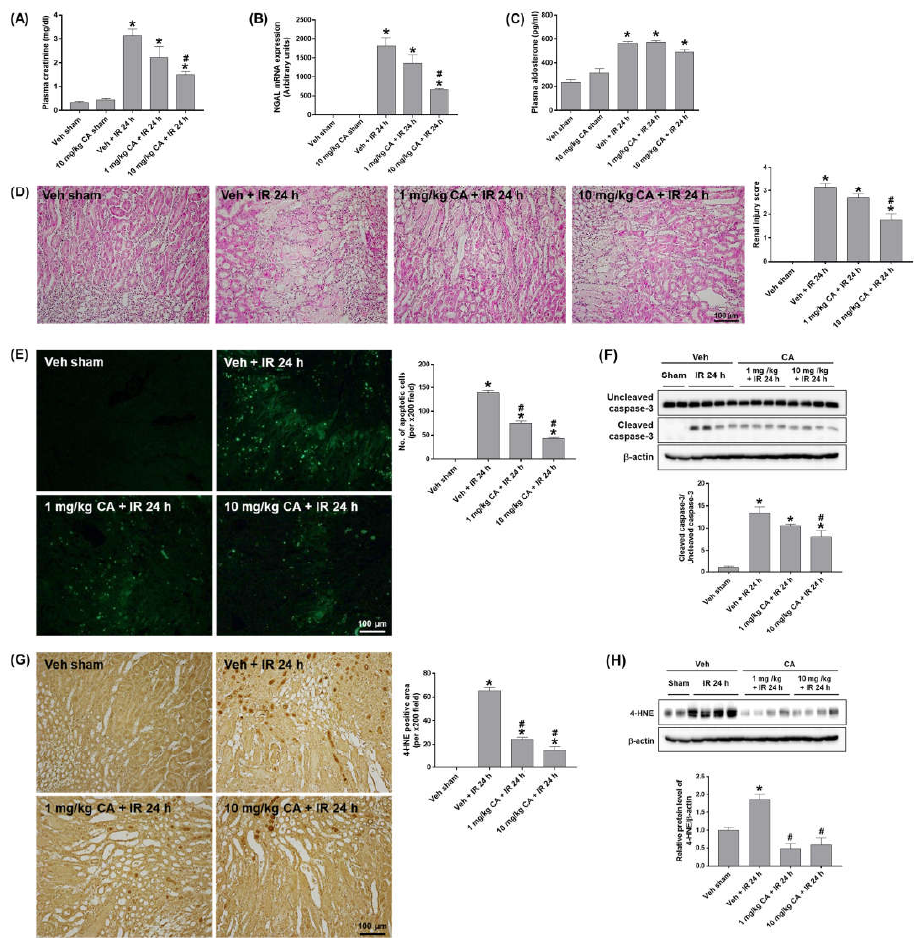
Figure 1. Canrenoic acid (CA) reduces plasma creatinine, tubular cell death, and oxidative stress in renal ischemia-reperfusion (IR) injury. C57BL/6 mice were subjected to 30 min of bilateral renal ischemia. CA (1 or 10 mg/kg) was injected intravenously 30 min prior to ischemia and sacrificed 24 h after reperfusion. Plasma creatinine levels ( A ), renal mRNA expression of NGAL ( B ), and plasma aldosterone levels ( C ). Representative images of H&E staining ( D ) and TUNEL staining ( E ) of kidney sections. The apoptotic cells were counted per × 200 field. Western blots showing the bands of cleaved and uncleaved caspase-3 in kidney tissue lysates; relative protein levels were normalized to levels of β -actin ( F ). Representative images of 4-HNE immunohistochemical staining of kidney sections; the positive cells were counted per × 200 field ( G ). Western blots showing the bands of 4-HNE in kidney tissue lysates; relative protein levels were normalized to levels of β -actin ( H ). The values are expressed as the means ± SEM. * p < 0.05 compared to sham group. # p < 0.05 compared to IR